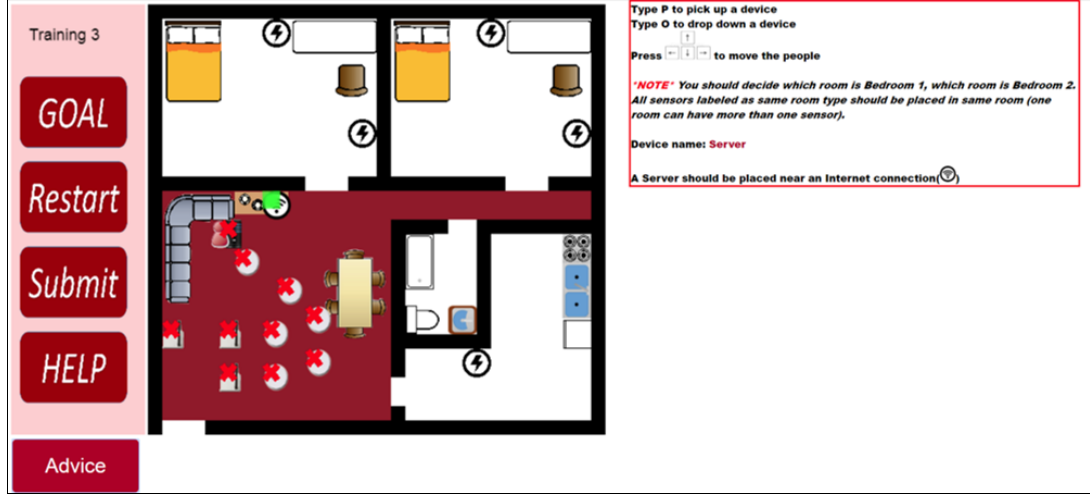
Figure 7. An example of hint for the